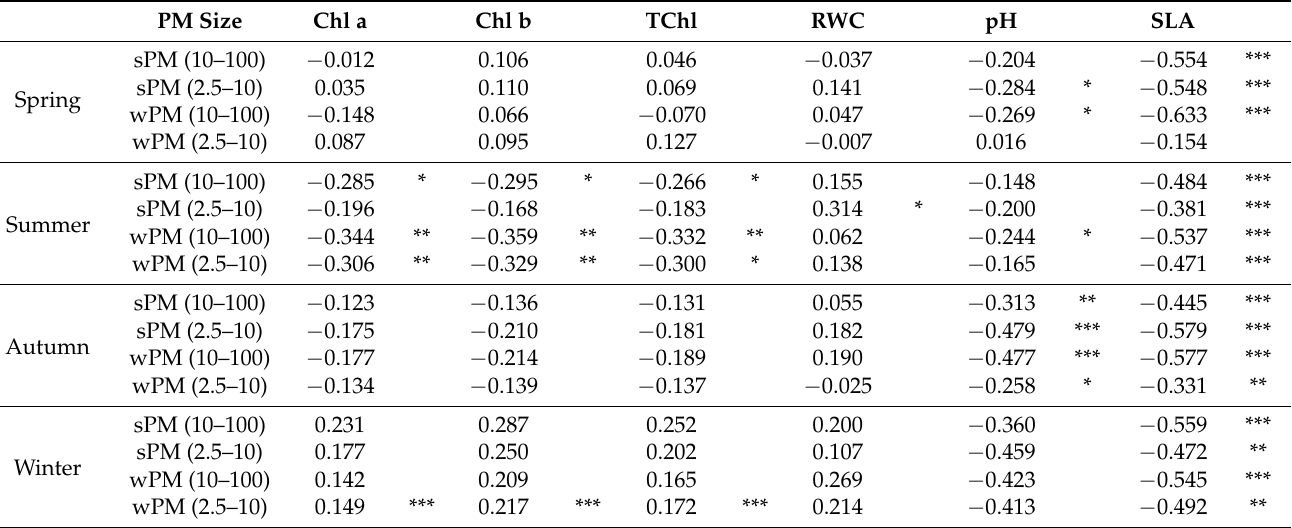
Table 5. Pearson correlation analysis of the accumulation of different fractions of particulate matter on leaf and leaf traits of 24 plant species in the four